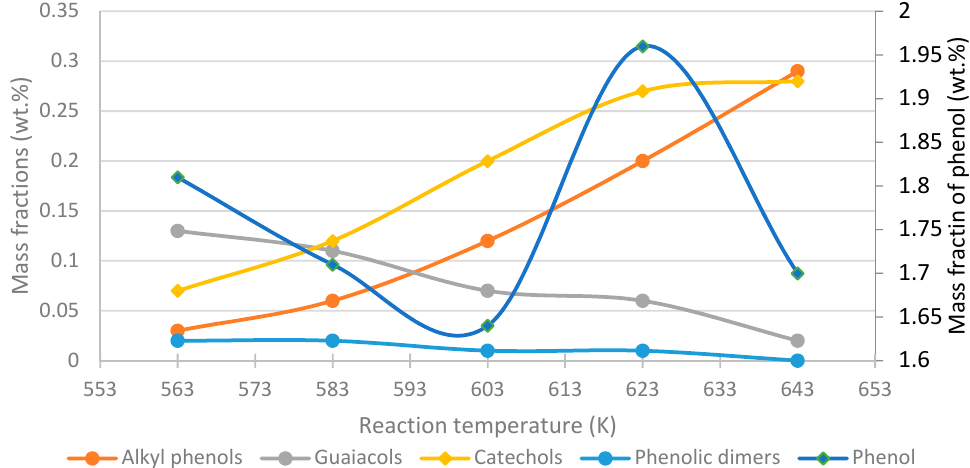
Figure 9. Effect of temperature on mass fractions of monocyclic aromatic compounds and phenolic dimers in WSO. Data is taken from [107]. The curves are guides to the eye.